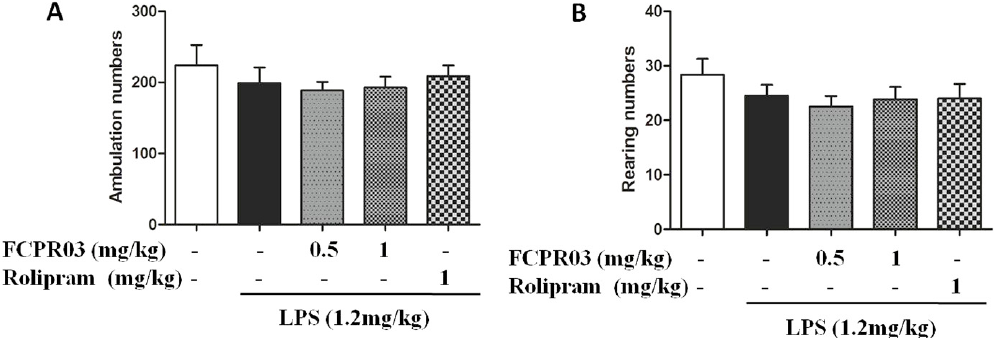
Figure 3. Effect of treatment of mice with FCPR03 or rolipram combined with LPS in the open field test. After seven consecutive days of pretreatment with FCPR03 (0.5 mg/kg or 1 mg/kg) or rolipram (1 mg/kg), mice were injected i.p. with saline or LPS (1.2 mg/kg, i.p.); 24 h after LPS injection, the ambulation activity ( A ) and rearing activity ( B ) were measured ( n = 8 per group).